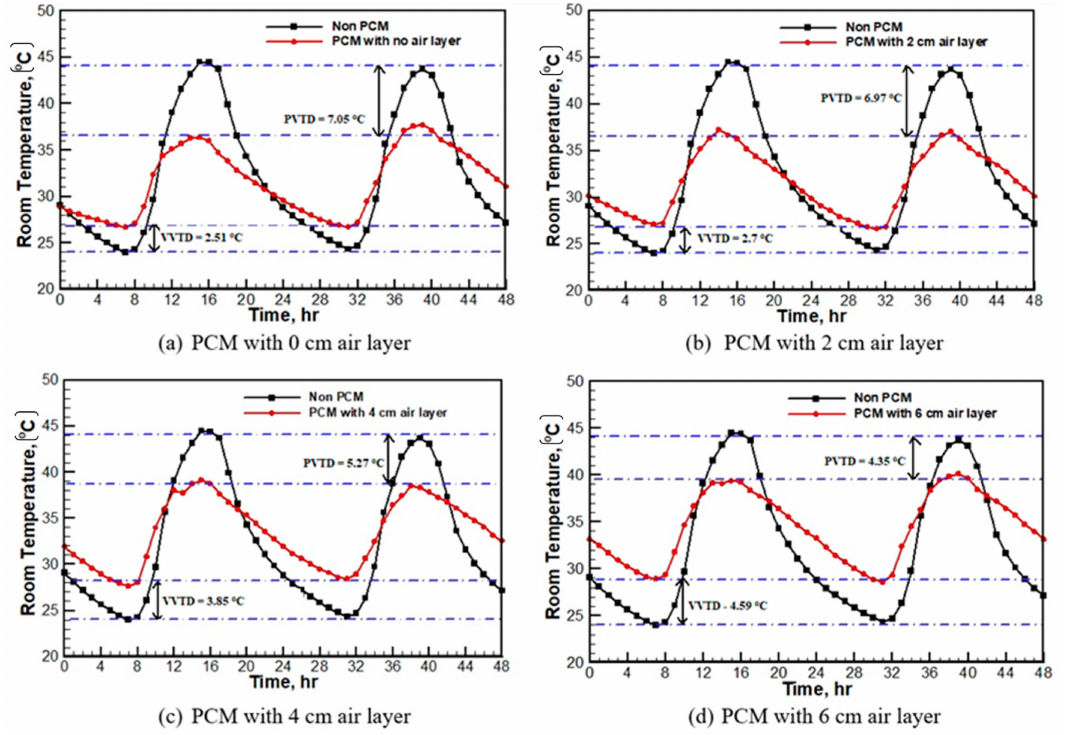
Figure 2. Average room temperature variation in the test